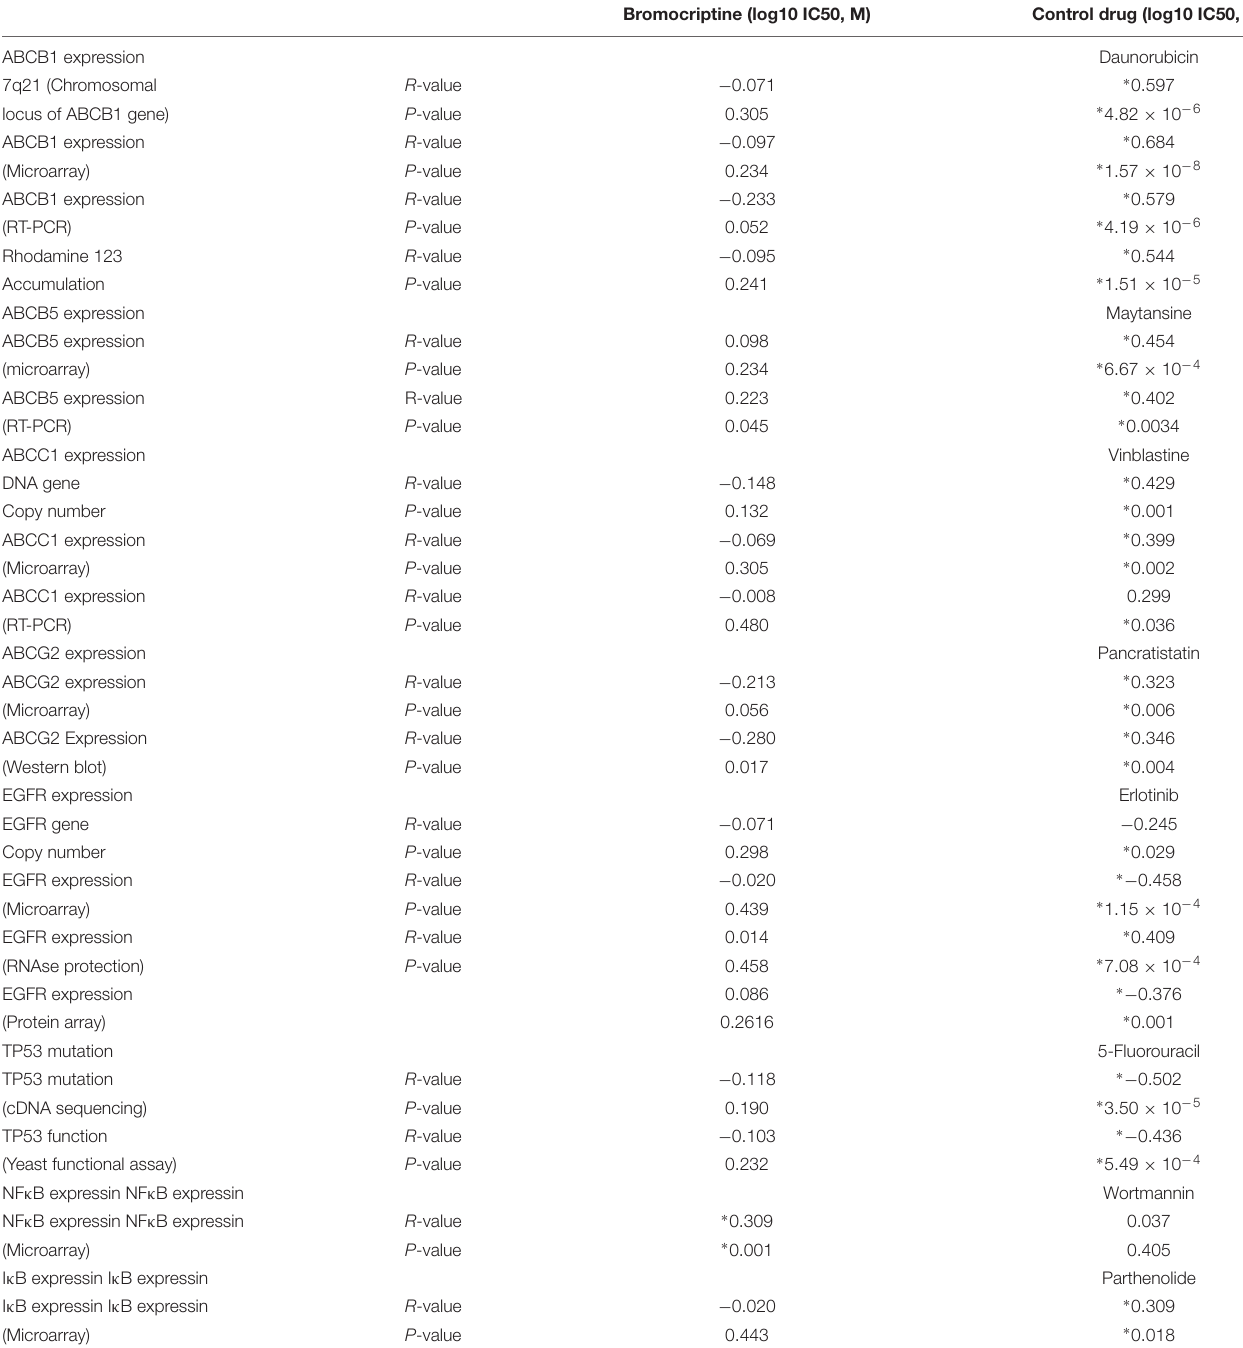
TABLE 2 | Correlation of log 10 IC 50 values for bromocriptine to drug resistance mechanisms (ABCB1, ABCB5, ABCC1, ABCG2, EGFR, TP53, NF κ B, and I κ B) in the NCI cell line